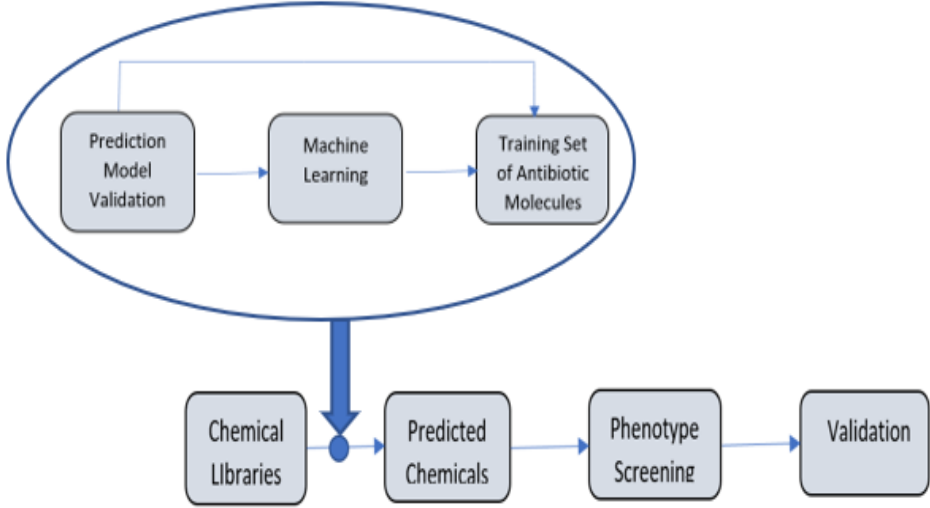
Figure 3. The proposed ML approach for accelerating drug and antibiotic discovery.